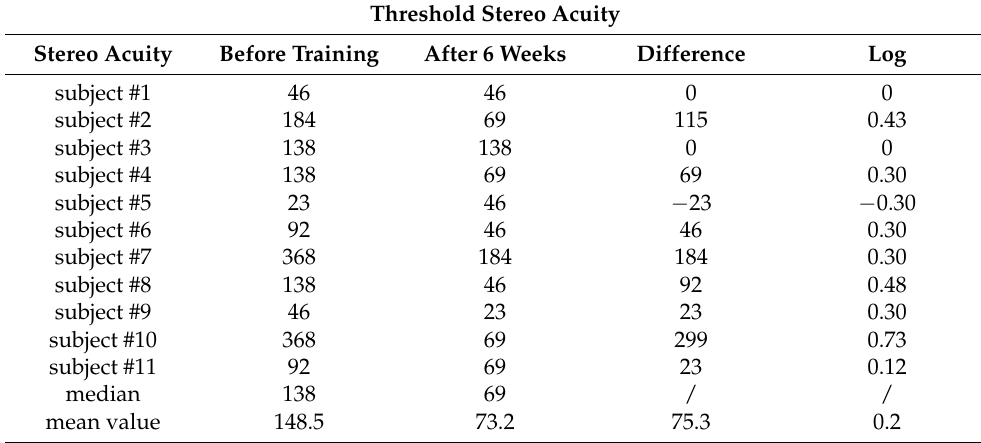
Table 1. Development of the stereo acuity in arcsec . Development of the stereo acuity in arcsec of the individual threshold before training and after six weeks of training, listing the difference in arcsec as well as the logarithmic of the difference.